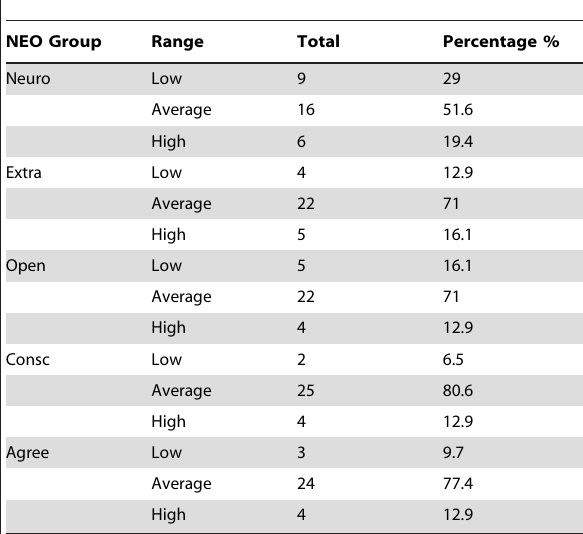
Table 1. Neo Group Membership including total numbers and